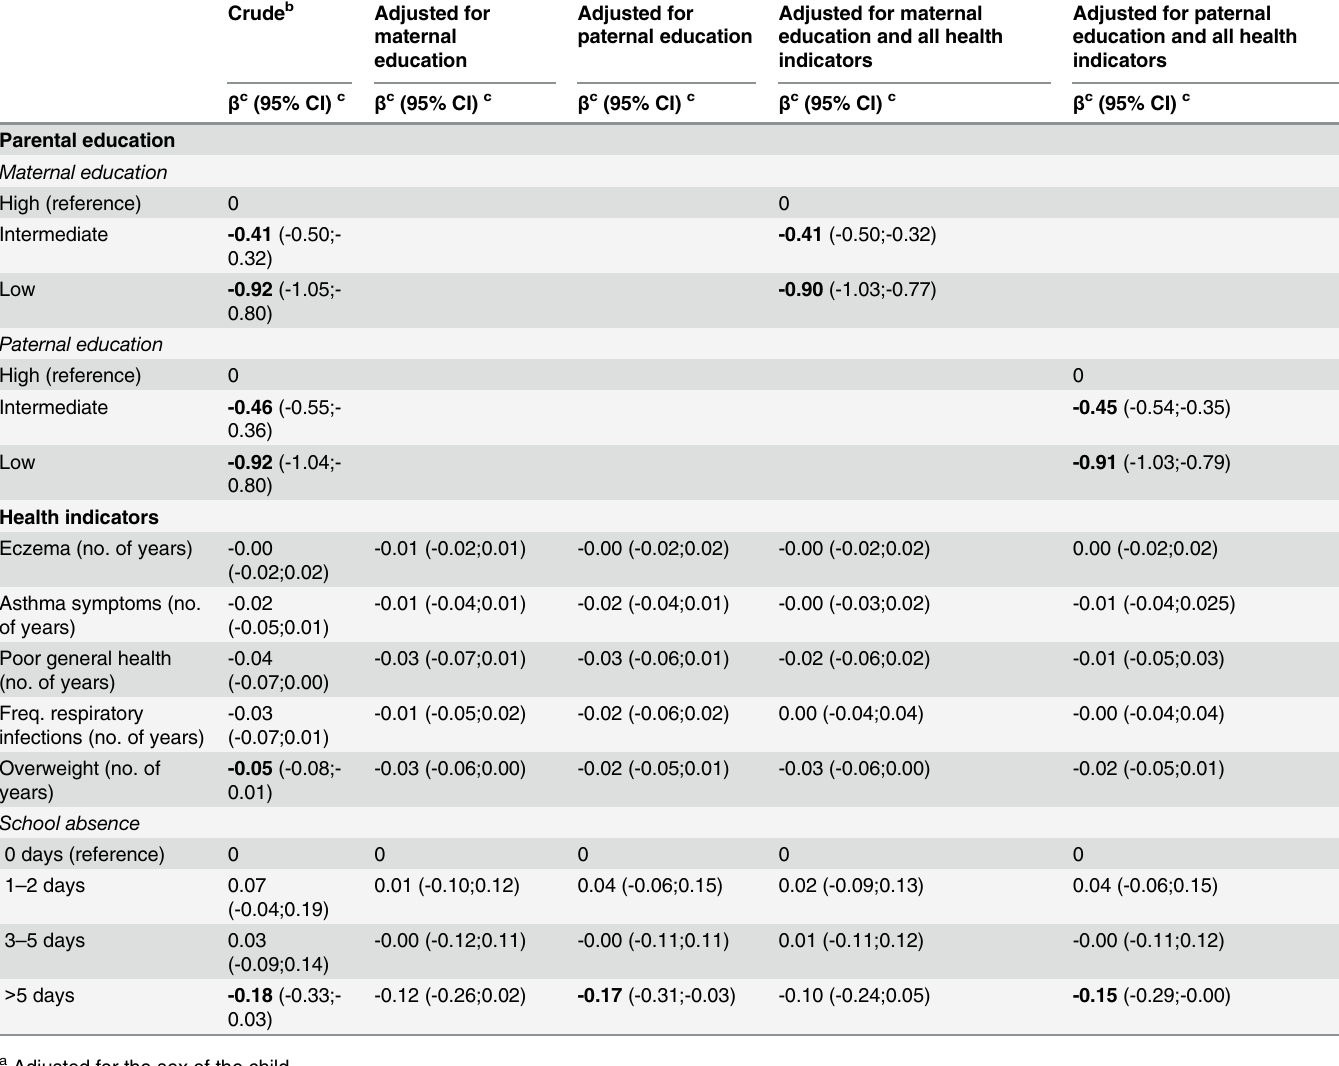
Table 3. Association of parental education and health indicators with school level assessment (Z-score) (n = 1,865) a . Crude